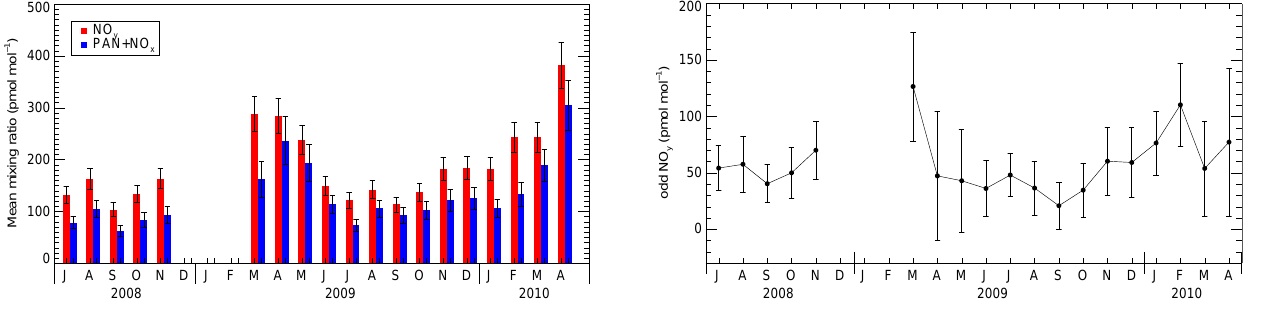
Figure 3. Monthly levels of odd NO y (calculated from the 30min averaged NO y , PAN, and NO x measurements) at Summit. Error bars represent the uncertainty in odd NO y mole fractions, deter- mined from the propagation of errors from PAN, NO x , and NO y